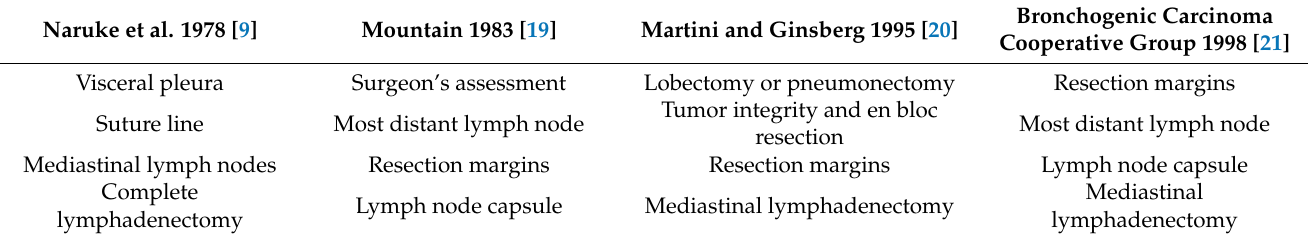
Table 2. Elements used to define complete